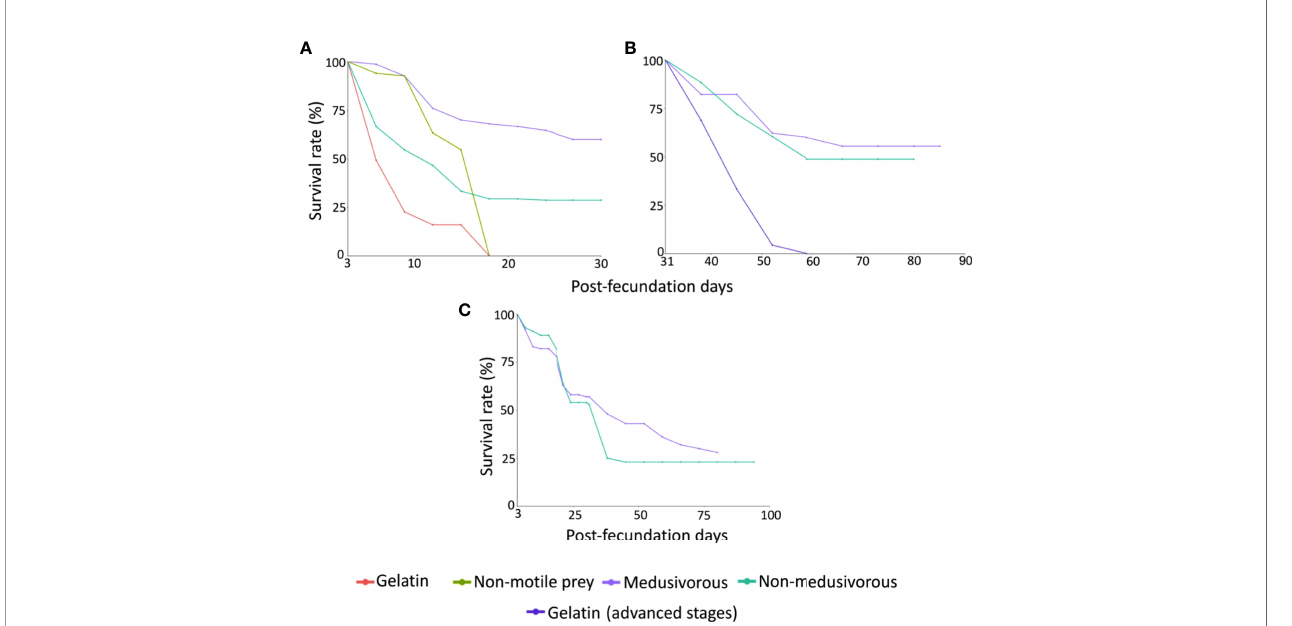
FIGURE 3 | Survival rates (%) of Pelagia noctiluca for: (A) Early stages of the fi rst generation (ephyra and metaephyra stages), (B) Advanced stages of the fi rst generation (juvenile and adult stages), (C) Early and advanced stages of the second generation. Food regimens: Culture 1, encapsulated food in gelatin; Culture 2, non-motile prey; Culture 3, medusivorous diet (presence of Aurelia sp.); Culture 3.1, medusivorous diet during early stages and gelatin from advanced stages; and Culture 4, non-medusivorous diet (absence of Aurelia